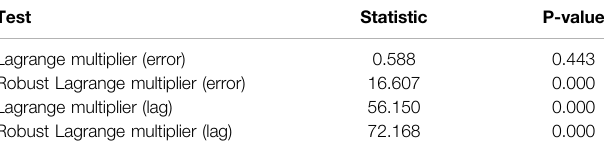
TABLE 3 | Results of the OLS regression